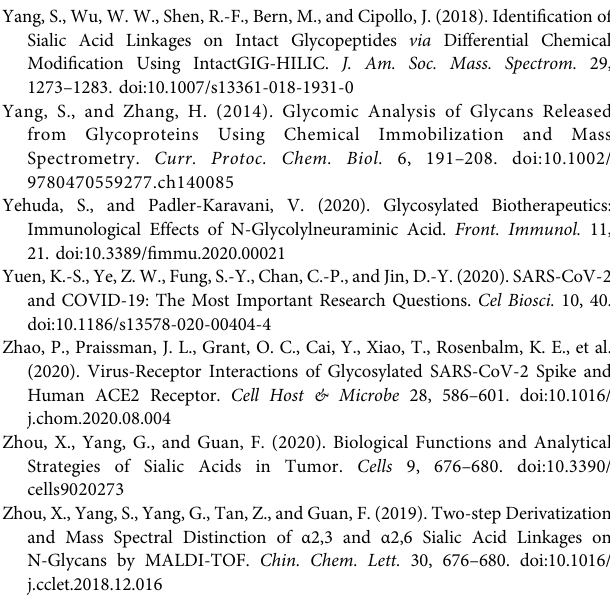
Protocol for a Serological Assay, Antigen Production, and Test Setup. Curr. Protoc. Microbiol. 57, e100.